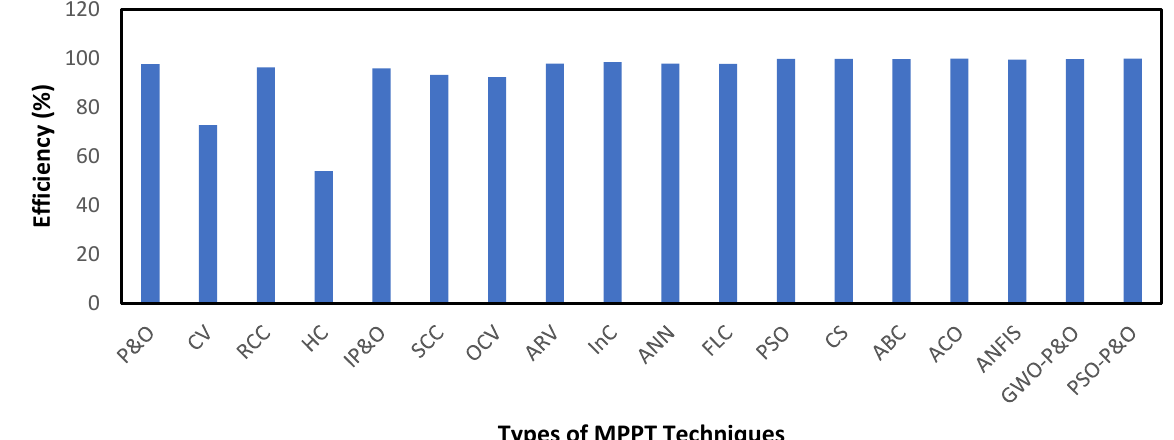
Figure 7. Reported efficiencies obtained from different MPPT techniques .